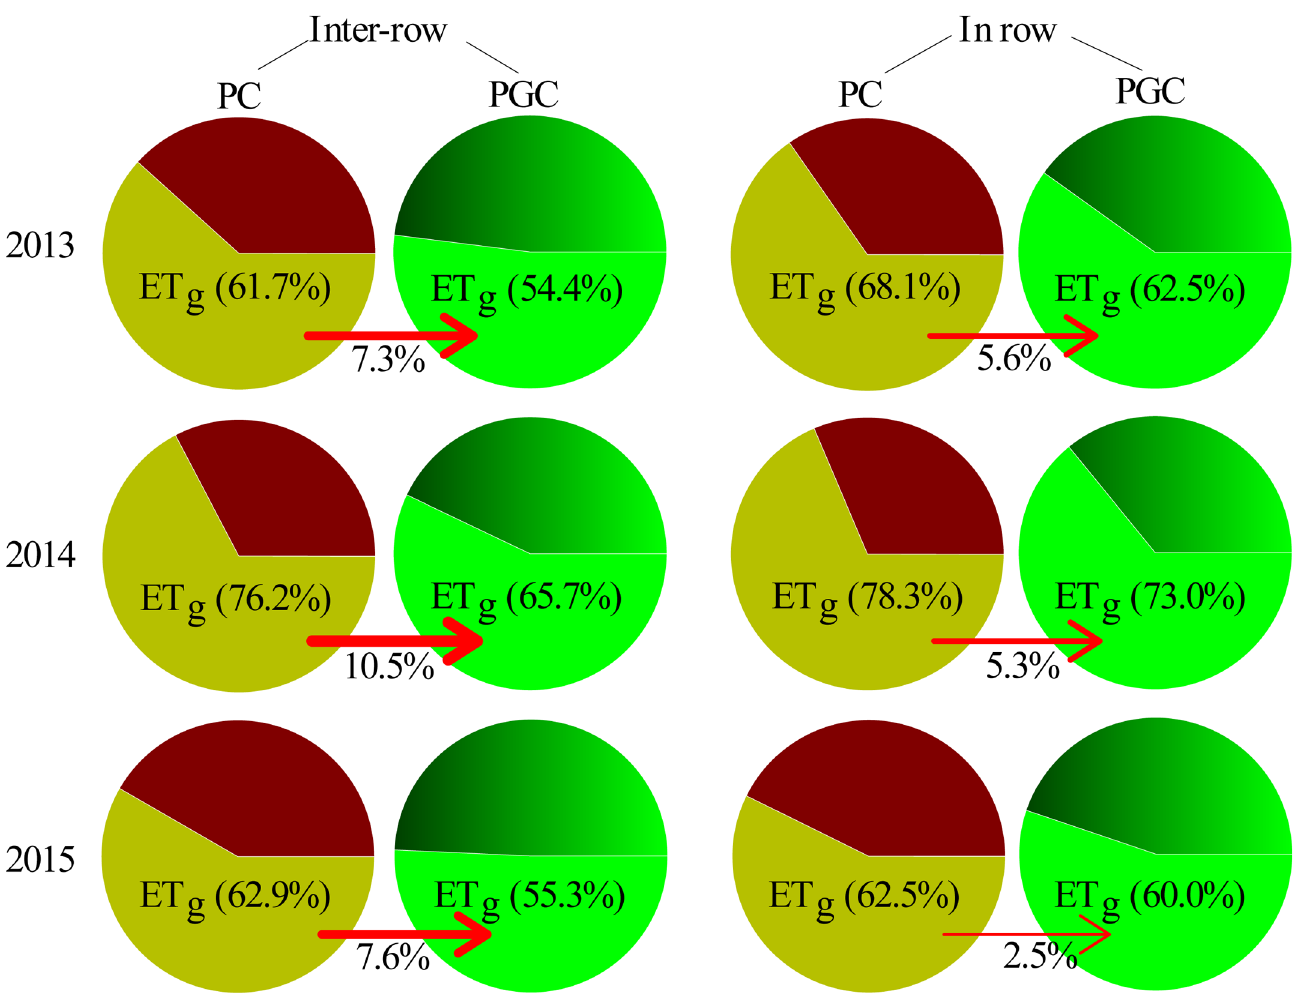
Fig 8. The proportion of evapotranspiration during the grass cover period (ETg) in total evapotranspiration (ETg/ET) in 2013, 2014 and 2015. The red arrow shows the deviationsof ETg/ET betweenPC and PGC for the inter-rowand in-row.